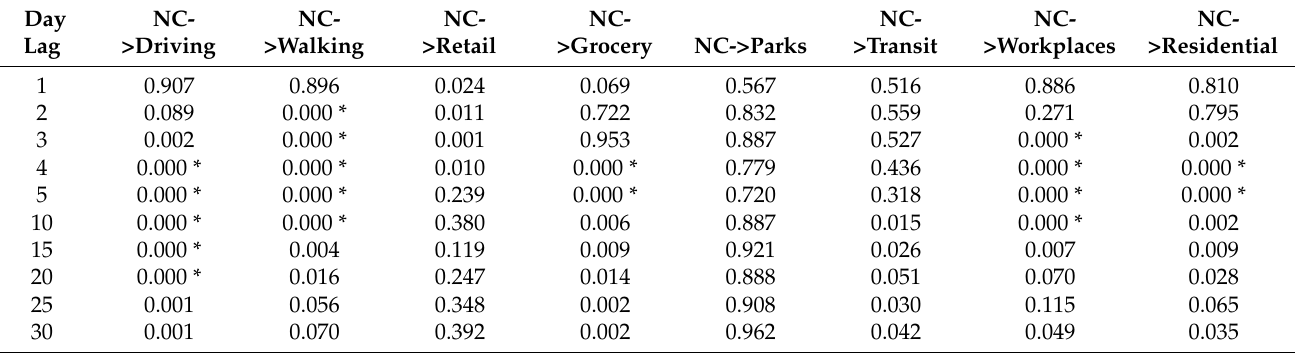
Table A13. New_cases (NC), Granger-cause mobility variables, and p -values in day lags in